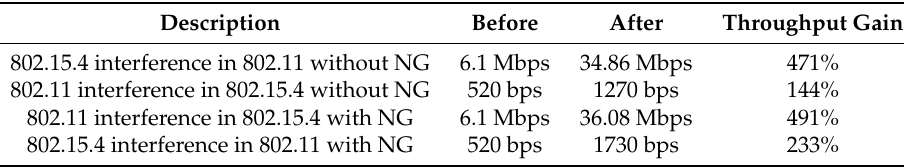
Table 4. Throughput results before and after changing the